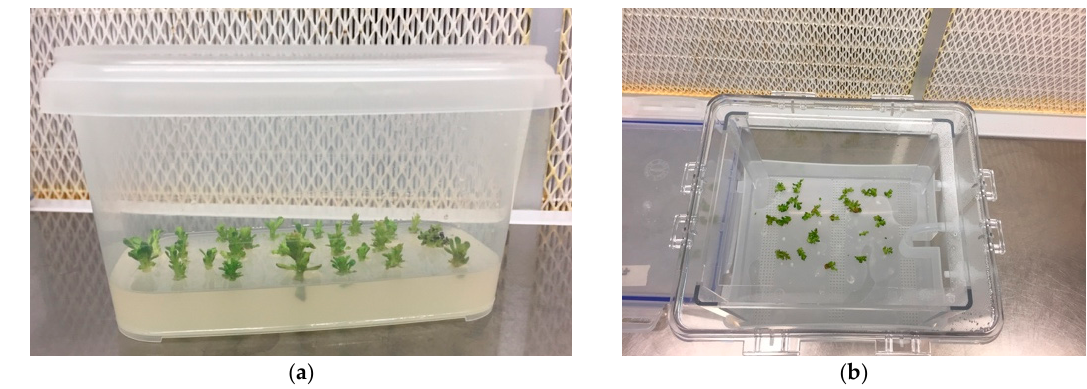
Figure 1. Placement of “Sal 39” explants to start the multiplication phase in the bioreactor ( a ) and on traditional solid medium ( b ).